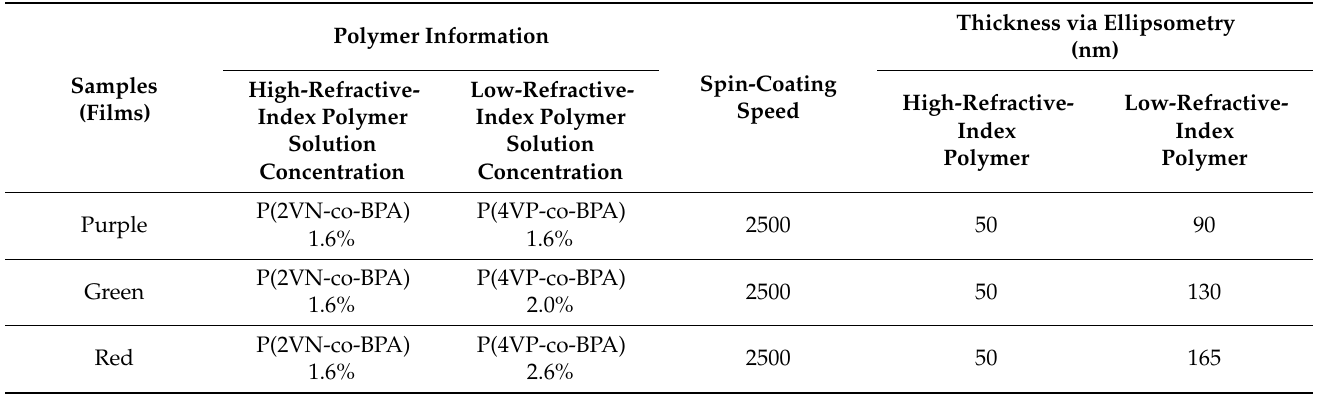
Table 1. Fabrication conditions and thickness